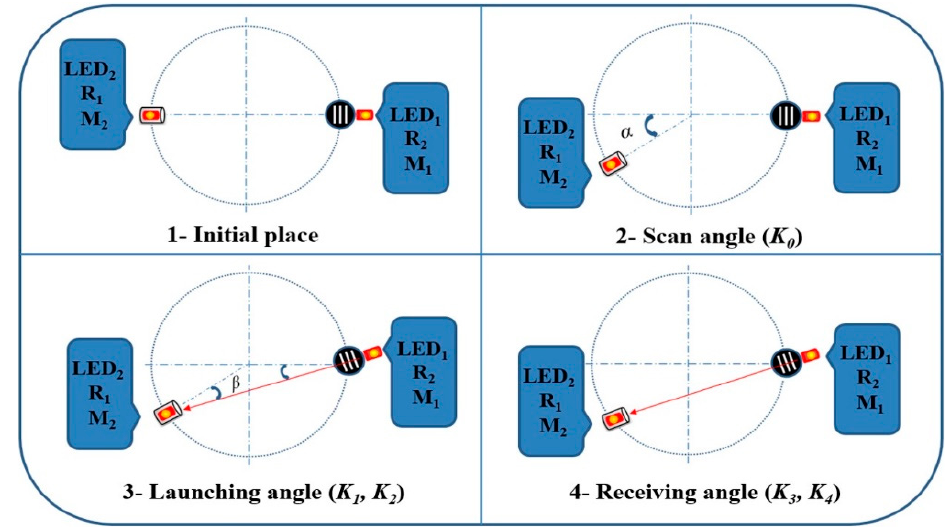
Figure 14. Schematic of the automatic scanning robot arm.